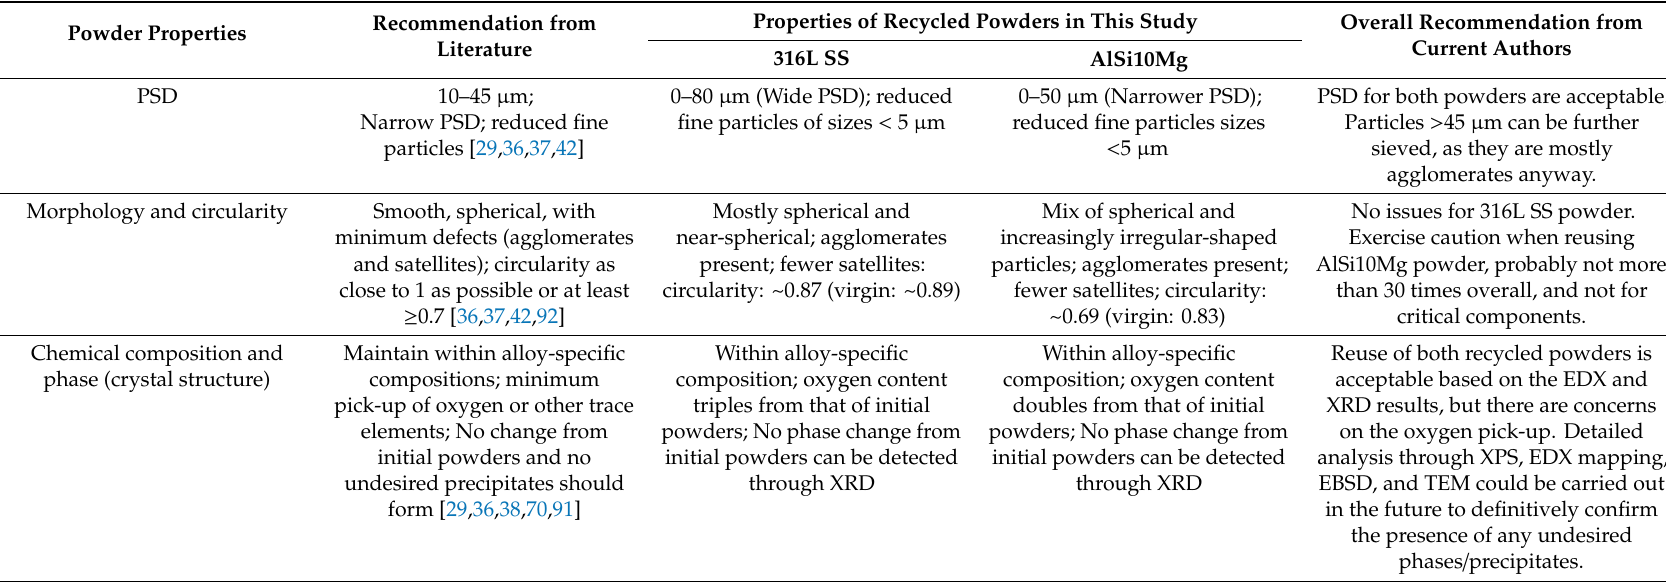
Table 3. Qualitative analysis on the recommendation of reuse of the recycled powders in the present study based on results established in available